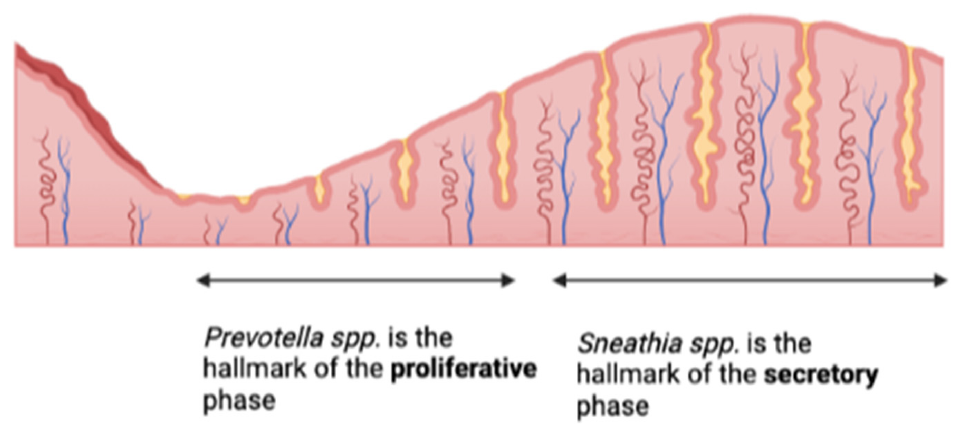
Figure 2. Endometrial microbiota changes under hormonal influence in different phases of the menstrual cycle [50].